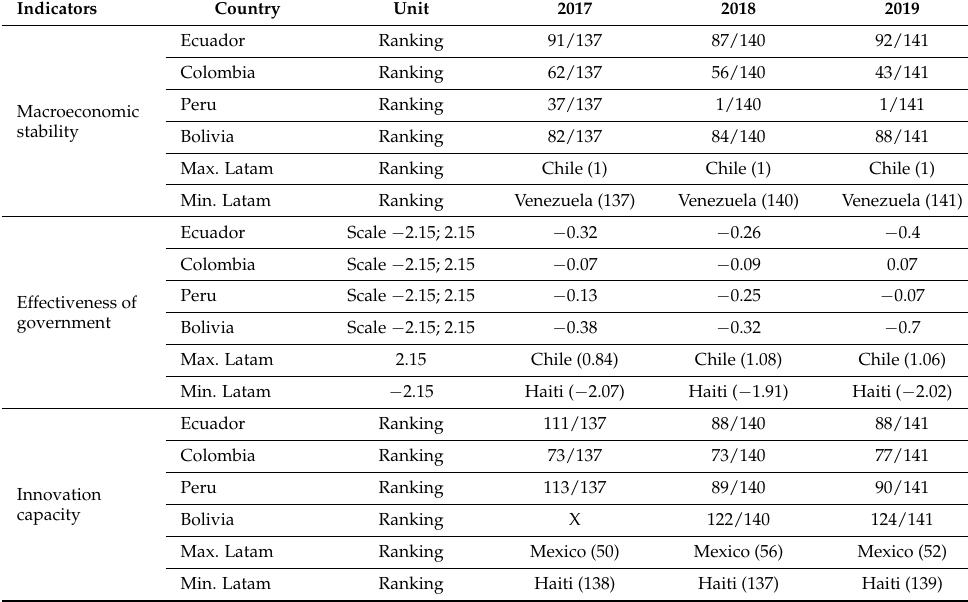
Table 12. The key indicators of country context dimension in the members of the Andean Community (in absolute